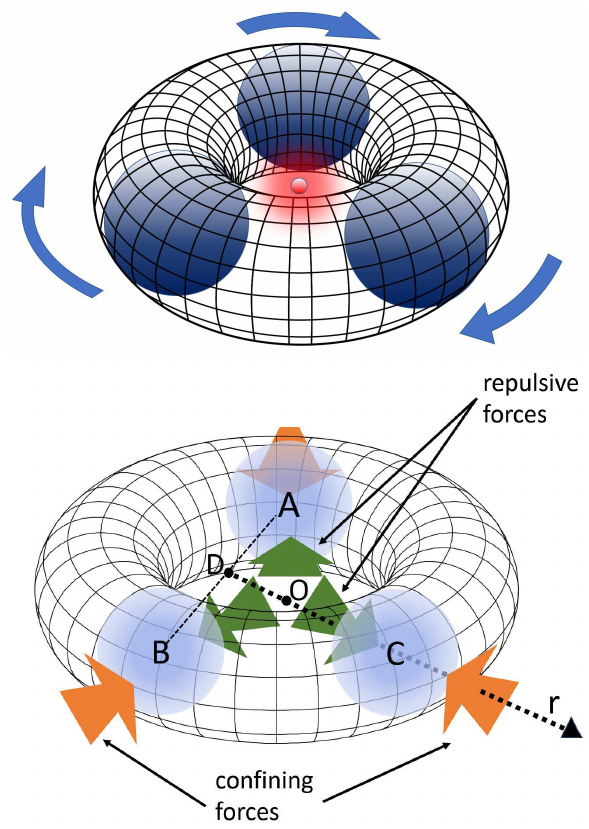
Figure 1: Rotating lepton model (RLM) of the proton. Top: Schematic comparison and synthesis of the bagel shape model of protons computed via model wave functions, constructed with Poincar ´